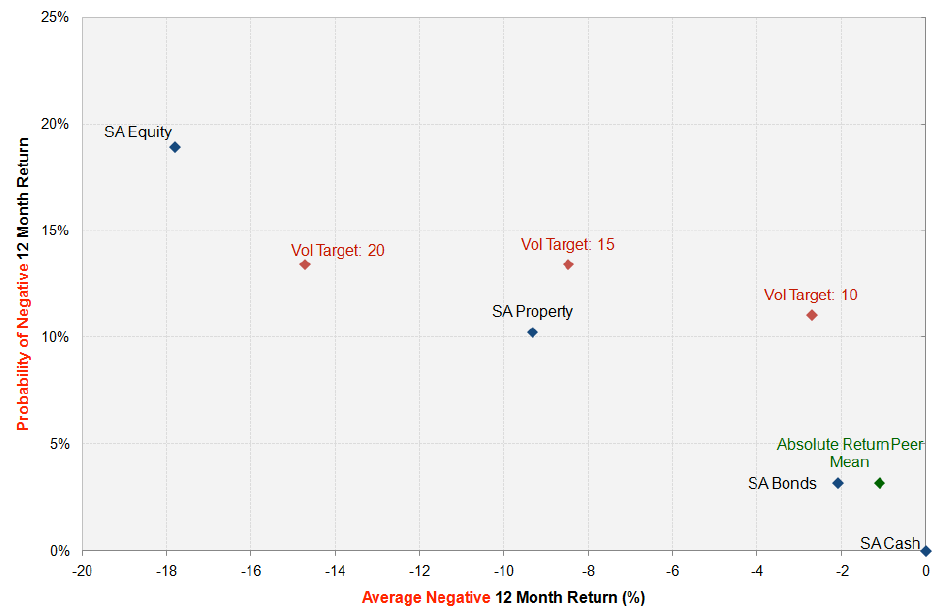
Asset class returns and Sharpe ratios Asset class Annualised return